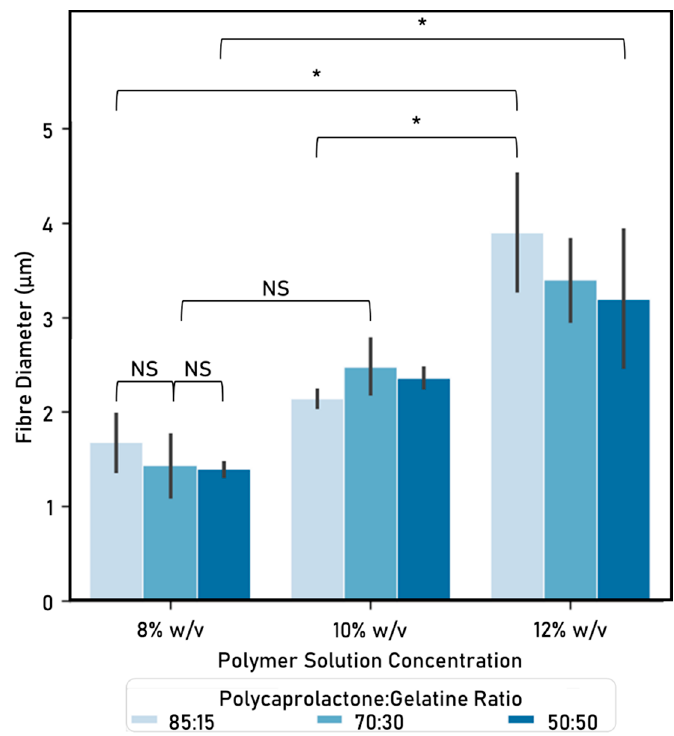
Figure 4. Fibre diameter (µm) (mean ± standard deviation). Electrospinning parameters: time: 15 s, solvent: TEF, voltage range: 9.82–10.56 kV, distance between nozzle and collector: 15 cm. Significant (*) and nonsignificant (NS) differences between samples are shown. (ANOVA/Tukey, p < 0.05; n = 24).